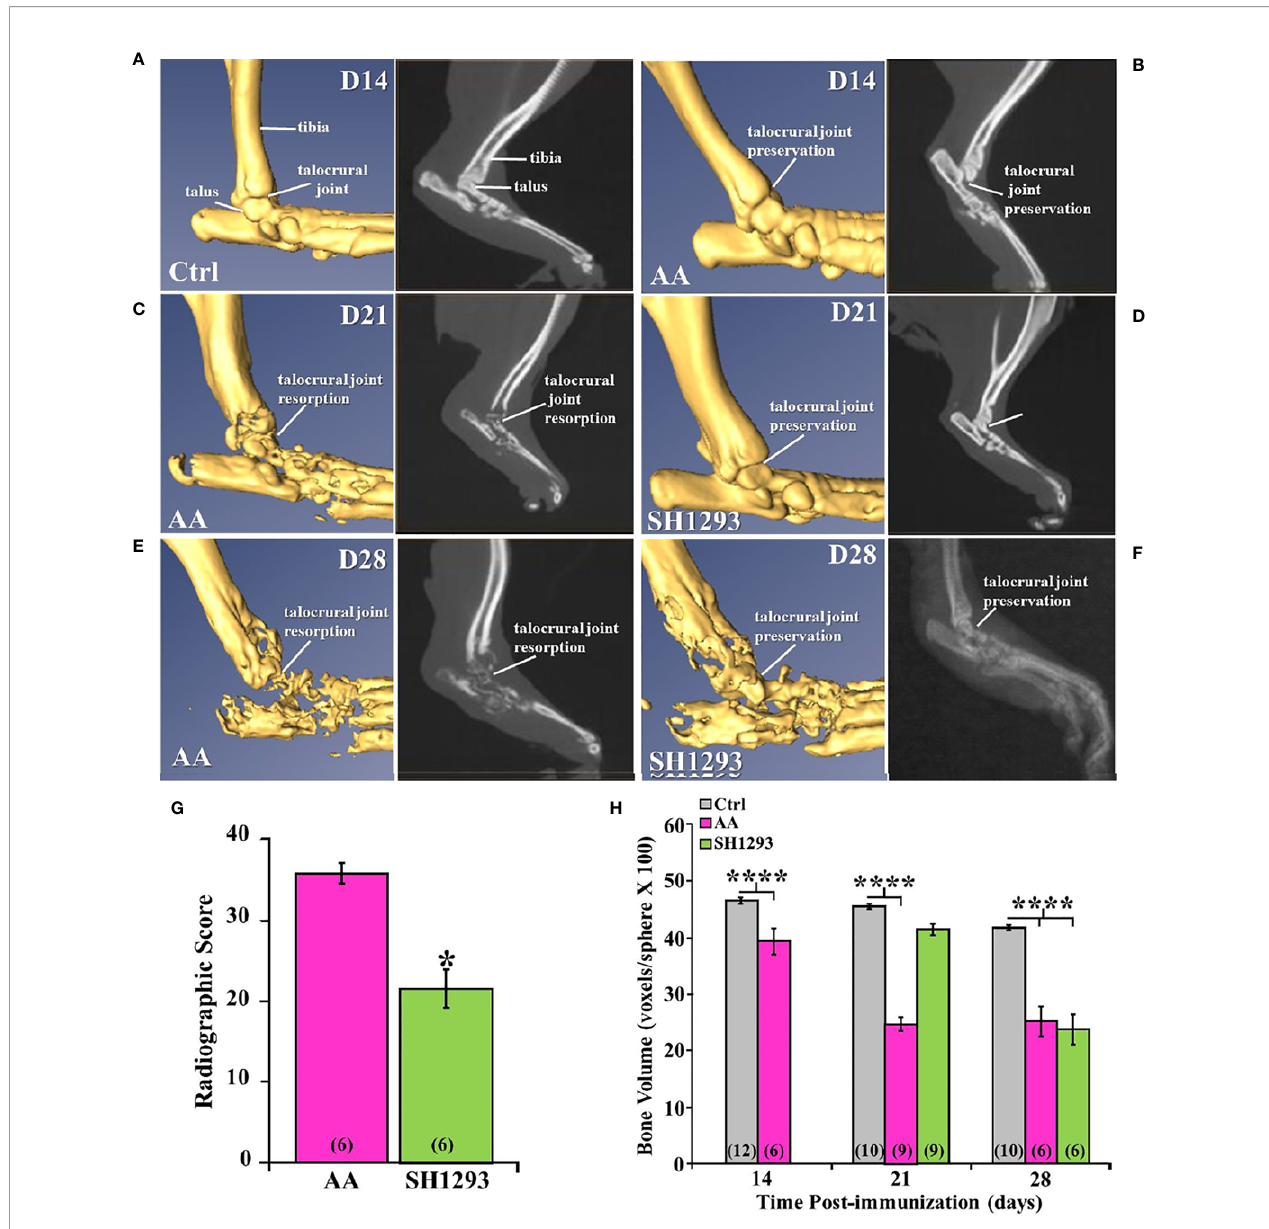
FIGURE 5 | Representative Micro-CT (left panels) and corresponding X-ray (right panels) images of the talocrural joint in the ankle of control (Ctrl) and arthritic rats (AA) with or without adrenergic drug treatment across time in days (D) . (A) Ctrl rats display intact joint structure and normal bone surfaces based on micro-CT (left) and radiographic (right) images of the hind limbs. (B) At D14, the talocrural joint structure was similar in AA and Ctrl rats based on micro-CT (left) and X-rays (right). The trochlea of the talus and articular surface of the tibia had regular borders and smooth articular surfaces. There were no signs of bone erosion or osteophyte formation at this time point. (C) By D21, arthritic changes in bone structure typical of RA are evident in the CT (left) and X-ray (right) images. The ankle joint and metatarsophalangeal joint exhibit bone erosions, bone resorption, narrowing of the joint spaces, soft tissue swelling and remodeling of the distal tibia, talus, and proximal foot in AA rats (left panel). X-ray (right) also reveal joint destruction, joint displacement and irregular bony proliferation in the distal tibia, talus and other small bones of the foot. (D) In contrast, SH1293 treated AA rats had remarkable sparing of joint destruction on D21 based on micro-CT (left) and X-ray (right) images. Soft tissue swelling was also reduced comparted to vehicle-treated AA rats. In fact, images more closely resembled those from Ctrl rats. (E) In AA rats on D28, CT (left) and X-ray (right) scans showed severe bone resorption in bones that form the talocrural joint and metacarpals of the foot. Periosteal bone formation resulting in joint space narrowing was evident at D28. (F) In SH1293 rats at D28, bone resorption near the talocrural joint, periosteal bone formation and joint space narrowing was still strikingly less than in AA rats treated with vehicle, but did progress substantially compared with Ctrl rats. (G) Radiographic scoring revealed a signi fi cant decrease in joint destruction in SH1293 rats compared with AA rats (*, p < 0.05). (H) Bone volume was signi fi cantly reduced in AA rats compared with Ctrl rats on D14 (****, p < 0.0001), D21 (****, p < 0.0001), and D28 (****, p < 0.0001). SH1293 had a sparing effect on bone volume at D21, as it did not differ from Ctrl rats. However, by D28 the sparing effect was lost (****, p < 0.0001). The n ’ s for each group are indicated in parentheses at the base of each bar of the graphs (G, H)